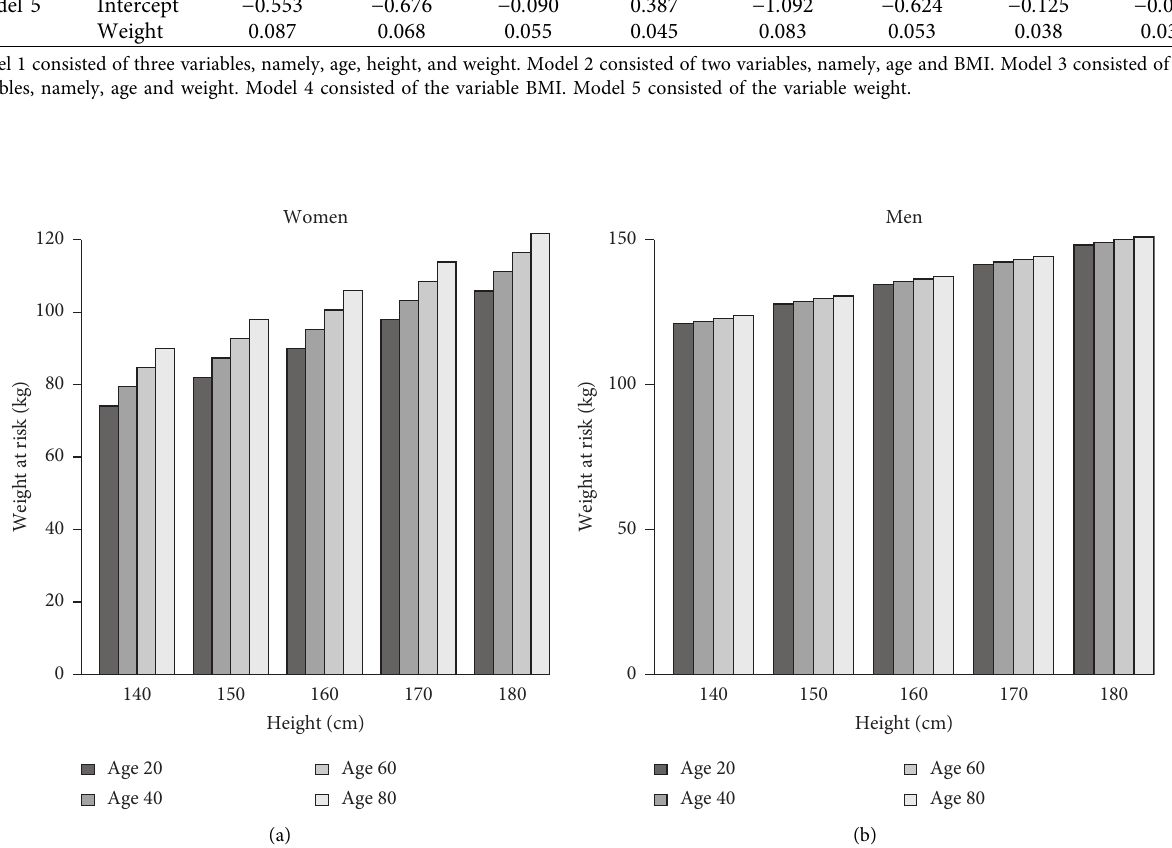
Figure 3: Risk weights for women (left panel) and for men (right panel) at 5th ICS from Model